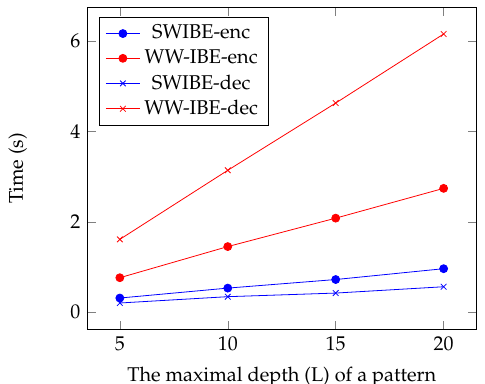
Figure 3. Encryption and decryption time in SWIBE and